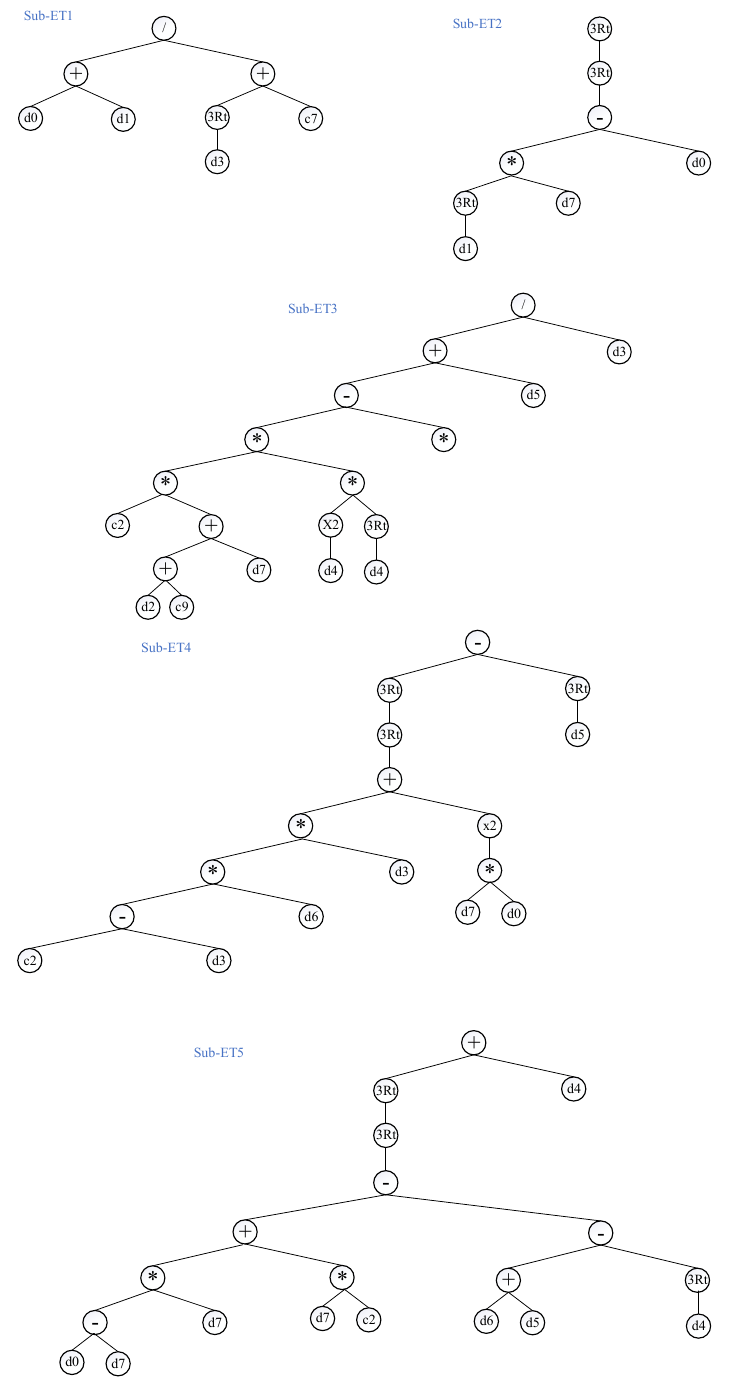
Figure 7. Expression trees derived from the best GEP model (* shows multiplication